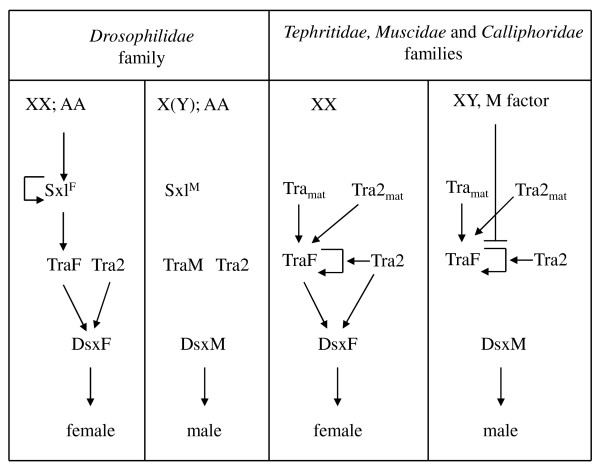
Comparison of the sex determination gene cascades between Drosophilidae (Drosophila), and Tephritidae (Ceratitis Anastrepha and Bactrocera), Muscidae (Musca) and Calliphoridae (Lucilia) families of Diptera. Tramat and Tra2mat indicate maternal Tra and Tra2 product. DsxF and DsxM stands for female and male Dsx protein, respectively. Though the maternal expression of gene tra-2 in Lucilia and the characterisation of this gene in Bactrocera have not been reported, both species are included in the scheme of this Figure because the analysis of tra in Bactrocera [17] and the analysis of tra and tra-2 in Lucilia [30] suggests their tra-2 genes have a similar function as in Ceratitis, Anastrepha and Musca. Scheme based on references 16, 17, 18, 23, 29, 30 and 36.